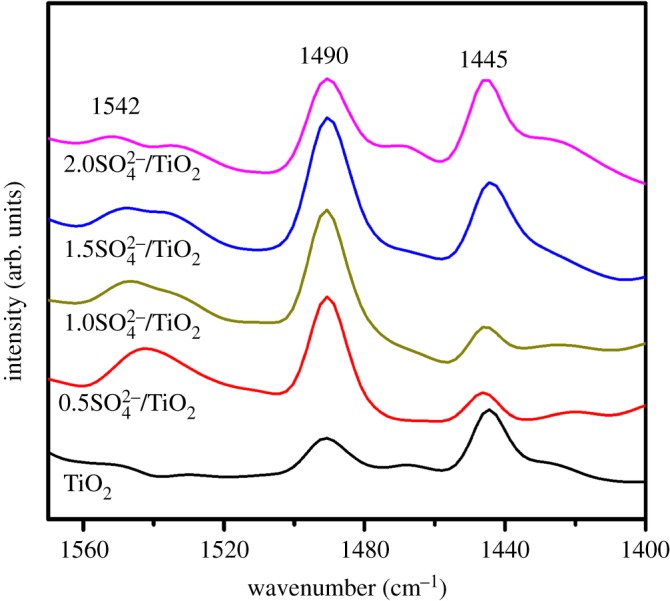
Py-IR spectra of the TiO2 and SO42−/TiO2 samples after degassing at 473 K.